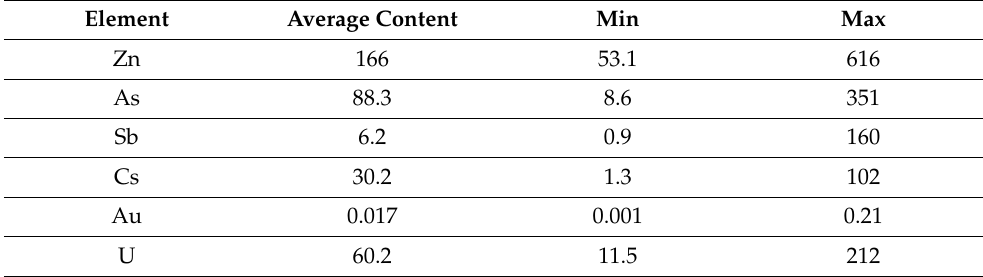
Table 1. The content of some associated elements in the Ge-bearing coal ash of the Tarbagatai deposit (ppm, ash basis; analyzed by instrumental neutron activation